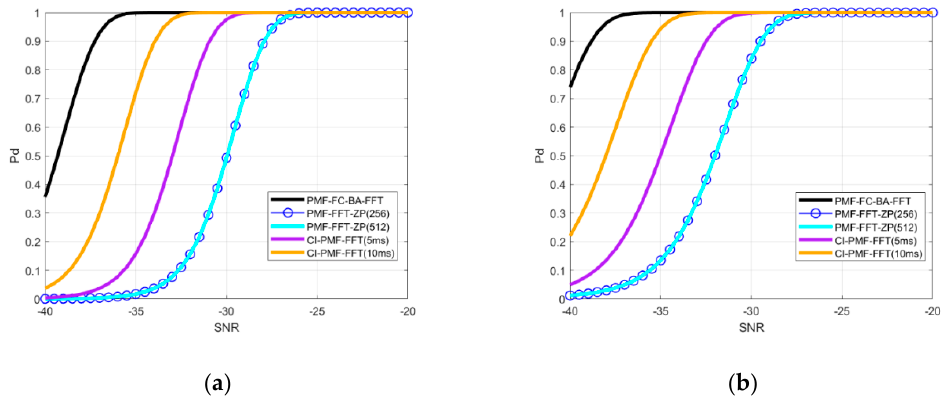
Figure 13. ( a ) Probability of false alarm corresponding to different SNR when the threshold coefficient was 5; ( b ) Probability of detection corresponding to different SNR when the threshold coefficient was 4.